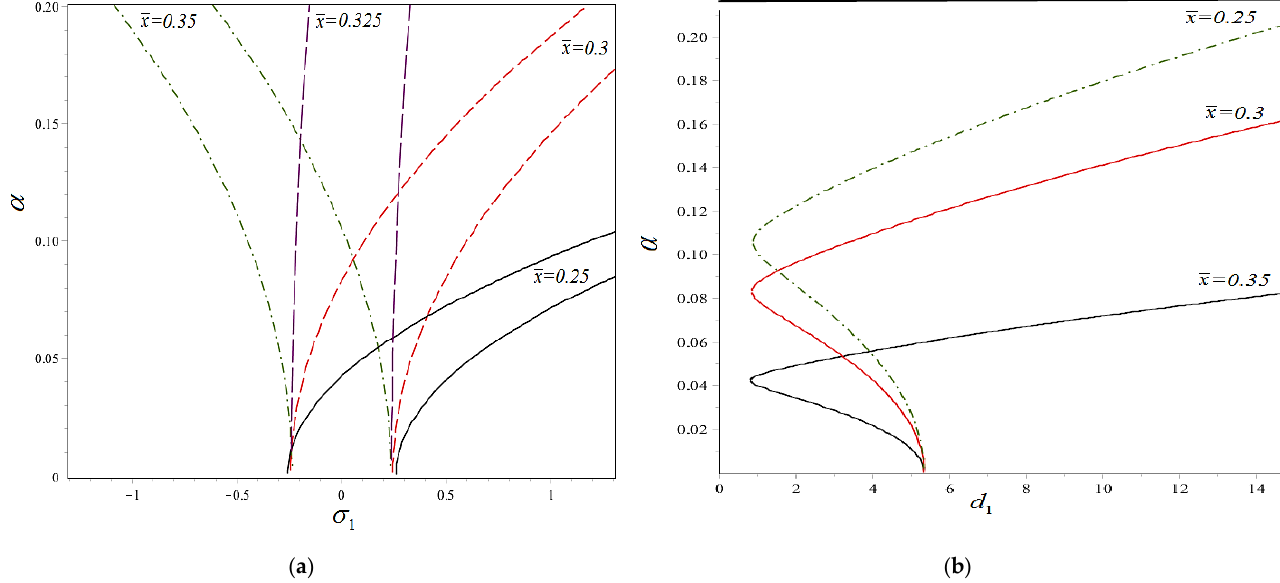
Figure 6. ( a ) Cubic curvature shape effect on the frequency response of the parametric resonance; ( b ) cubic curvature shape effect on the response curve of the parametric resonance.